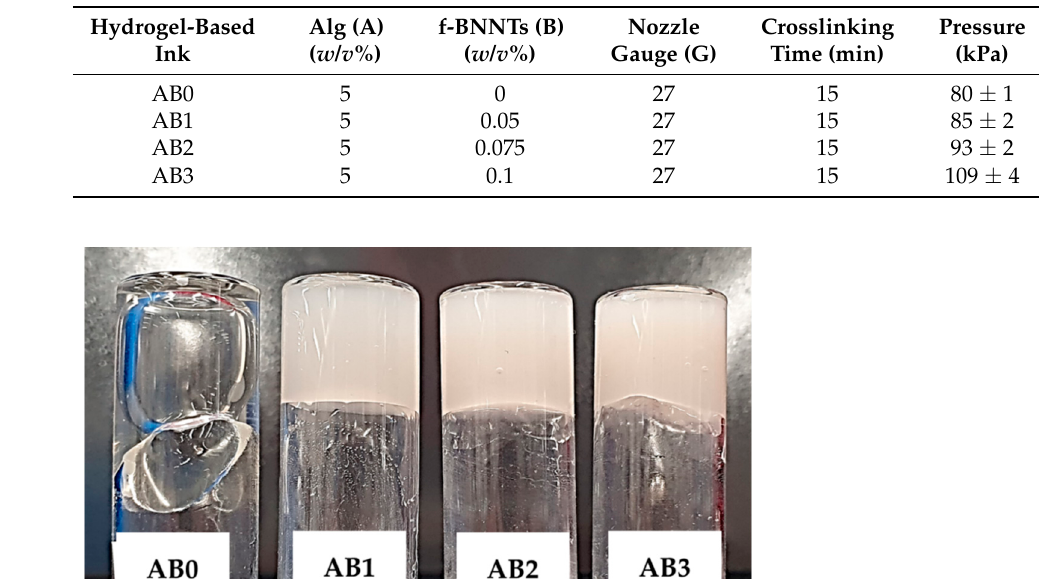
Table 1. The ink composition of nanocomposites hydrogel-based ink solutions and the parameters used for 3D bioprinting parameters.